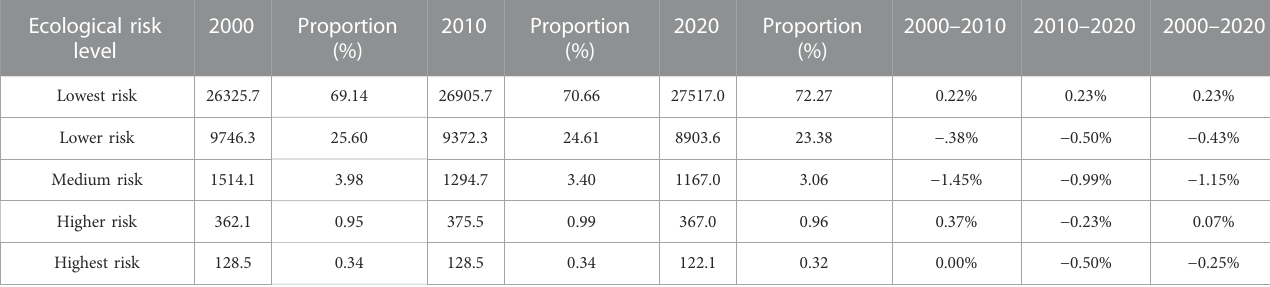
TABLE 4 Ecological risk grade area and dynamic attitude from 2000 to 2020 (km 2 ). Ecological risk